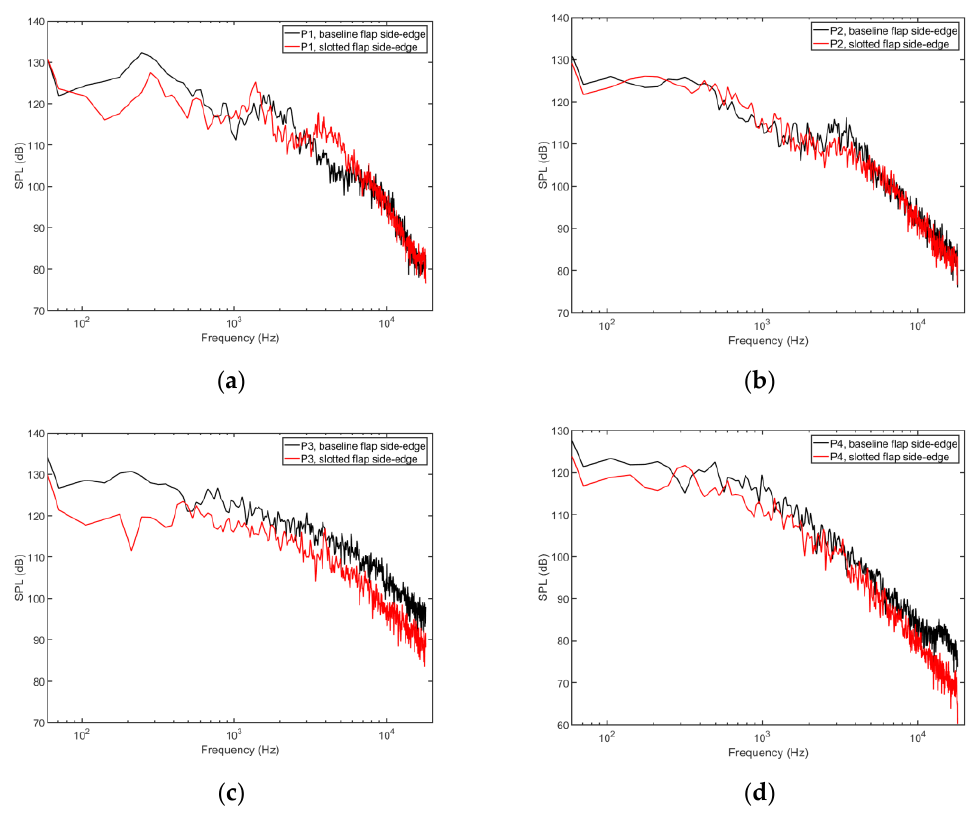
Figure 12. The comparison of the pressure fluctuations spectra at four different sensors on the flap side-edge between the baseline flap side-edge and slotted flap side-edge. ( a ) P1; ( b ) P2; ( c ) P3; ( d ) P4.